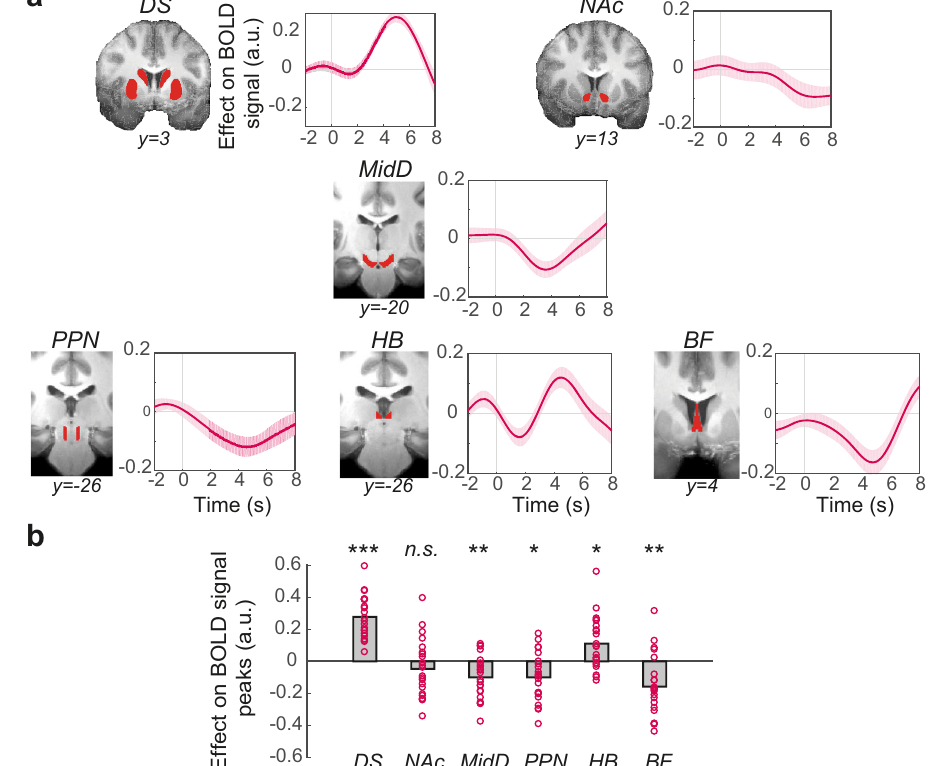
Fig. 2 A subset of subcortical structures encodes the act/no-act decision. a ROI time-course analysis of the a priori selected subcortical structures, showing the relationship between BOLD and act/no-act decision. The panel next to each time-course shows the corresponding anatomical ROI overlaid on averaged structural image of all subjects in standard space. The y axis is based on the FSL MNI152 standard brain in which y = 0 is the dorsal posterior corner of the anterior commissure (ac). The lines and shadings show the mean and standard error of the β weights across the participants, respectively. Time zero is the trial onset (appearance of the offer). Note that the hemodynamic lag means that a BOLD signal change re fl ects neural activity approximately 6 s earlier. DS dorsal striatum, NAc nucleus accumbens, MidD midbrain dopaminergic system, PPN pedunculopontine nucleus, HB habenula, BF basal forebrain. b There was a signi fi cant relationship between BOLD activity and the act/no-act decision in DS ( P = 1.7E − 08), MidD ( P = 0.008), PPN ( P = 0.01), HB ( P = 0.01), and BF ( P = 0.004). Each ring represents one participant ( n = 22). The grey columns illustrate the group mean. Signi fi cance testing on time-course data was performed by using a leave-one-out procedure on the group peak signal. Two-sided, one-sample t tests with Holm − Bonferroni correction. a.u. arbitrary units. * P < 0.05, ** P < 0.01, *** P < 0.001, n.s. not signi fi cant. See also Supplementary Fig. S2 for a related